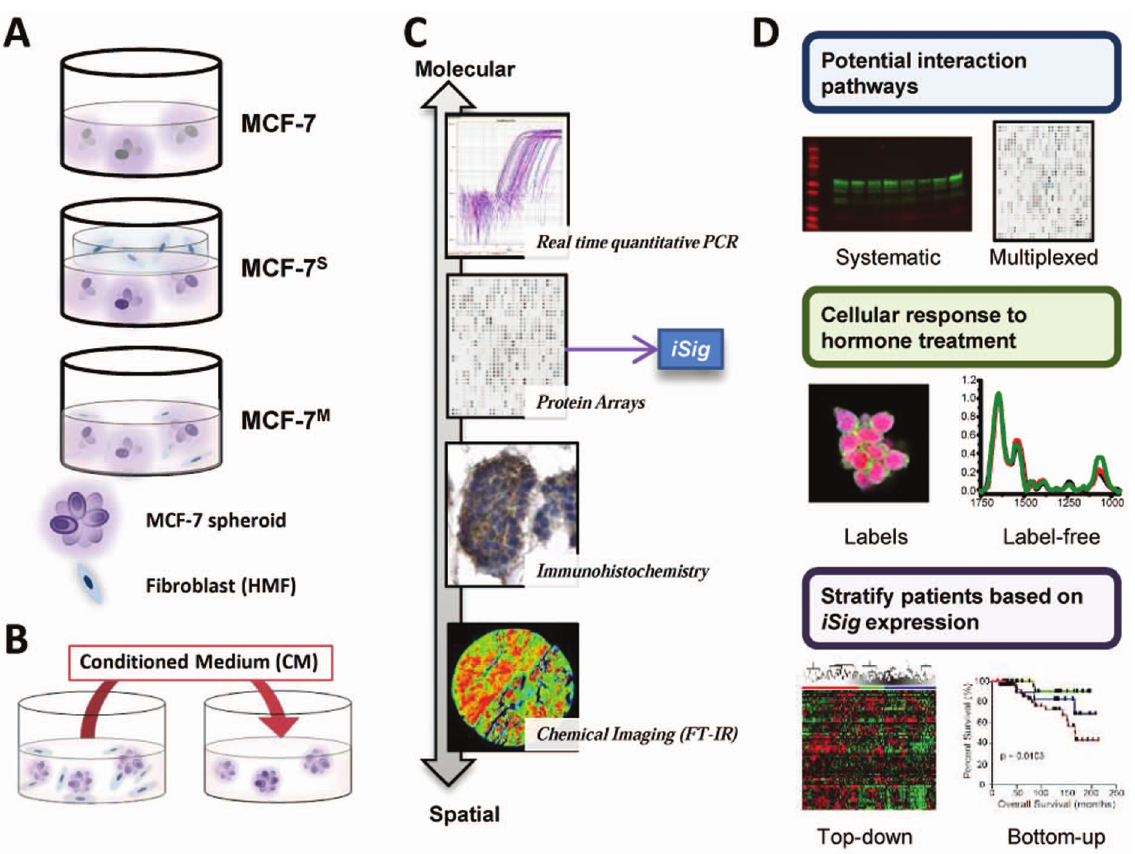
Figure 1. Three-dimensional co-culture models and analytical approaches in this study. Schematic of the several three-dimensional co- culture models we utilized to study the interactions between MCF-7 breast cancer cells and primary mammary fibroblasts. The MCF-7 were grown as spheroids in a Matrigel overlay culture. Fibroblasts were incorporated either in a direct-contact mixed culture (MCF-7 M ) or in a separate collagen layer in a sandwich culture (MCF-7 S ). To study the effects of paracrine signaling, conditioned medium (CM) studies were done in which CM was taken from the mixed culture and used to treat MCF-7 or normal mammary epithelial cells (HMEC) grown alone. The CM was also profiled using protein arrays to obtain the secreted protein interaction signature (iSig). We used gene expression and phenotypic assays to study response to hormone and the expression of markers of EMT. This molecular profiling approach was correlated to label-free FT-IR spectroscopic imaging and also gene expression from patient